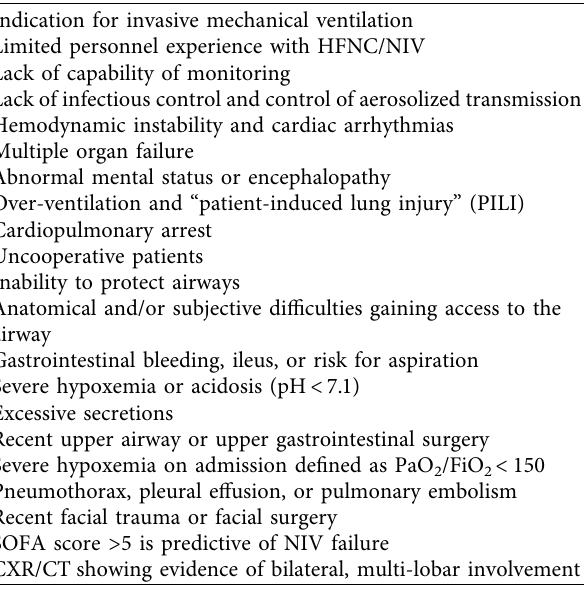
Table 2: Contraindications for NIV in COVID patients.